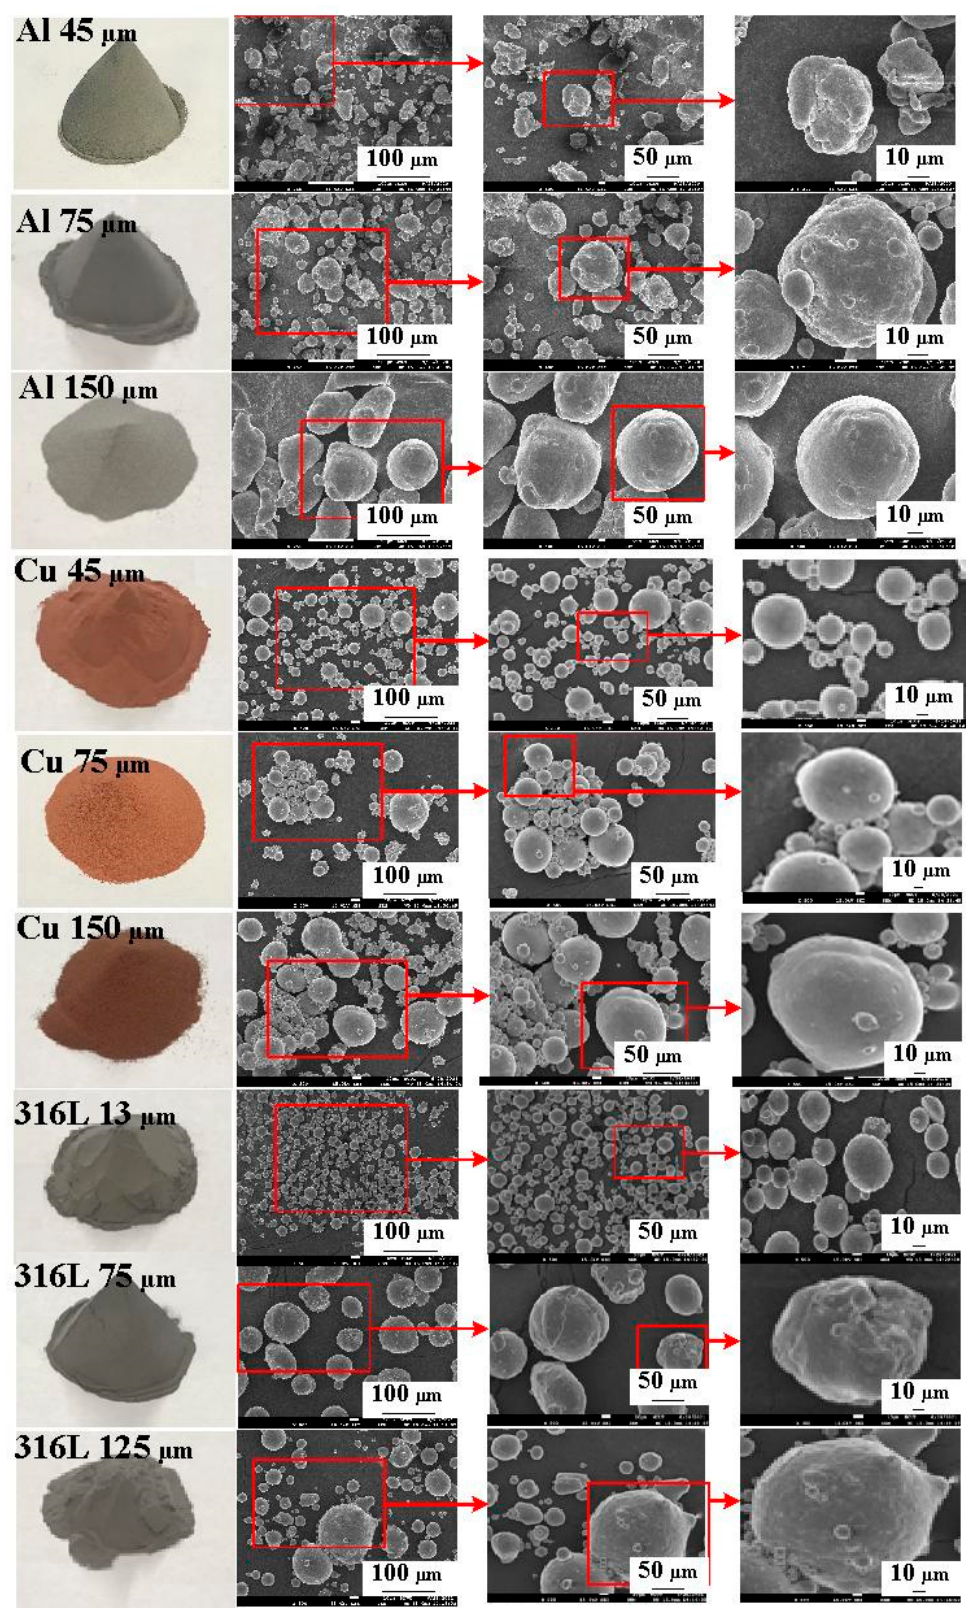
Figure 2. Three different kinds of fillers used in this study.